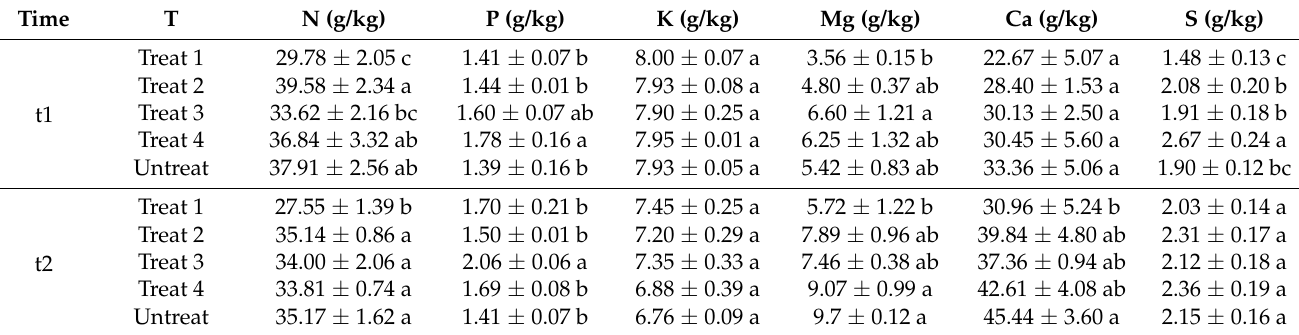
Table 2. Macro- and meso-elements composition of leaves at the two sampling dates. In column and for each period, different letters indicate significant differences ( p < 0.05).